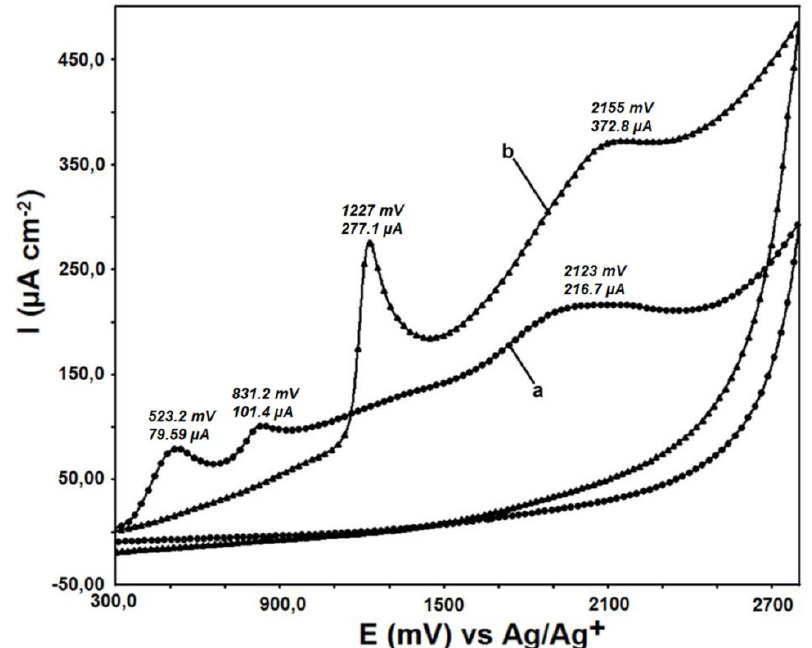
Figure 3. Overlaying of surface voltammograms of the first cycle ( a ) QR modification on bare GC and ( b ) QR modification on DTO/GC surface from +300 mV to +2,800 mV, 10 cycles, 100 mV·s − 1 sweeping